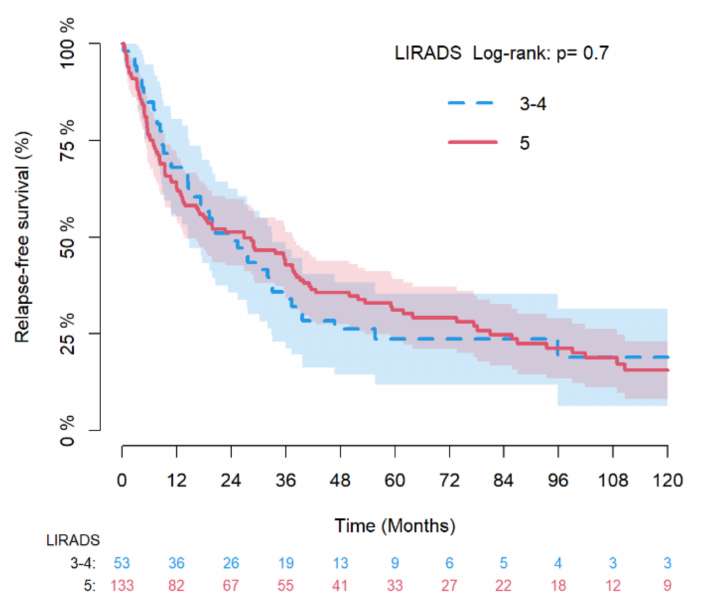
Figure 2. Kaplan–Meier estimates of relapse-free survival by LR-3/4 vs LR-5 with log-rank